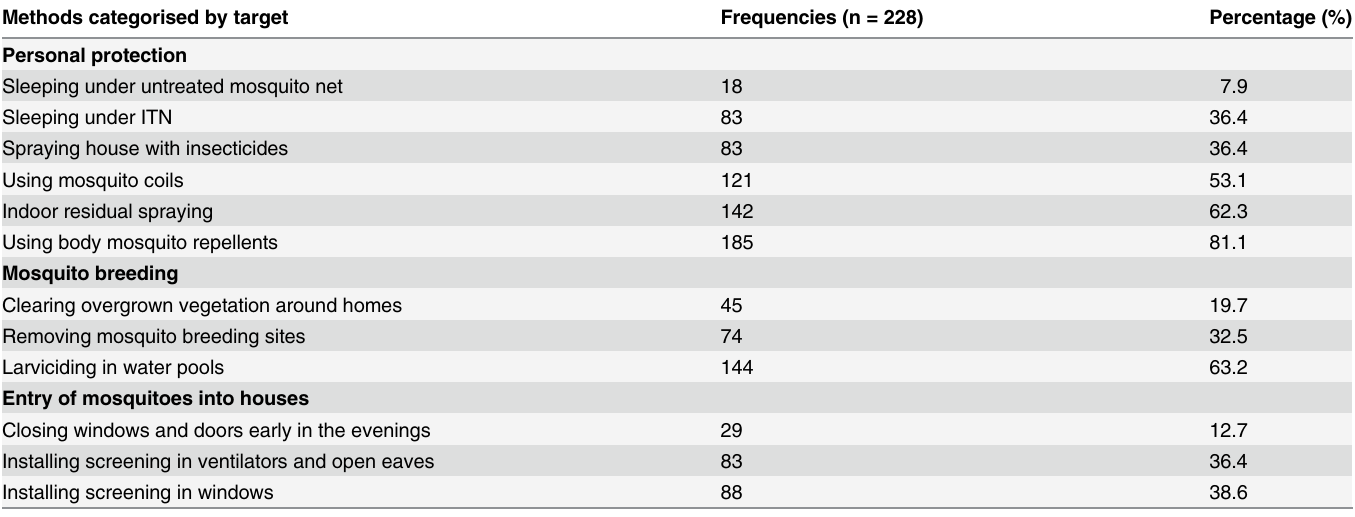
Table 3. Malaria prevention methods that households would not use in the integrated approach.